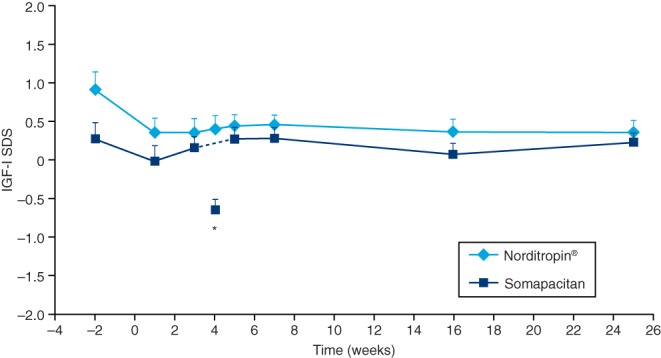
Serum IGF-I SDS levels (mean + s.e.m.) vs time. *Week 4 is the trough value, measured before administration of somapacitan. SDS, standard deviation score.